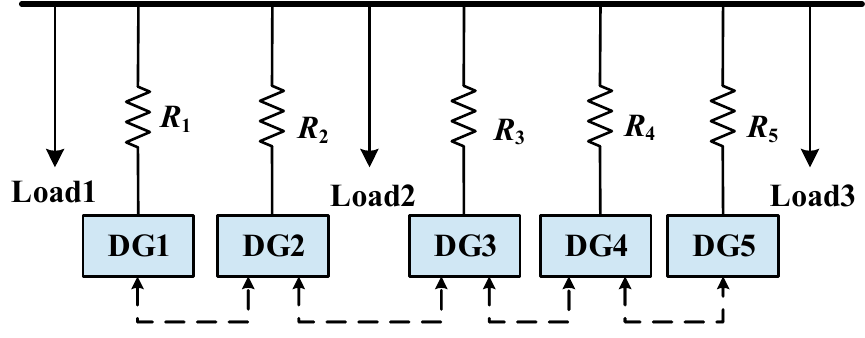
Figure 5. Configuration of the test MG. Table 1. Network and control parameters.